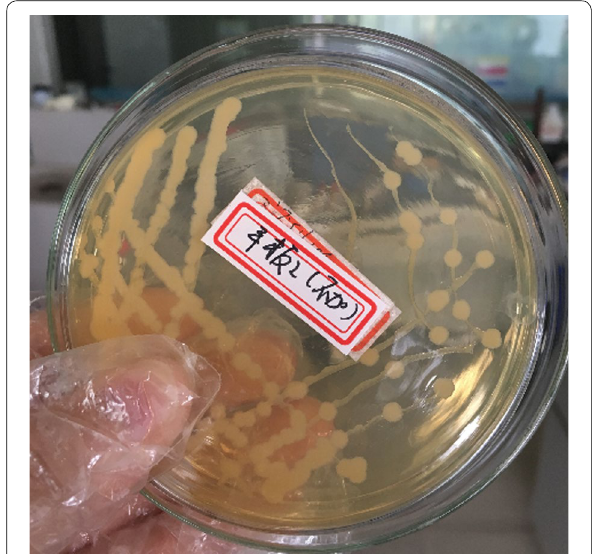
Fig. 1 The colony of ZJUTB06-99 on